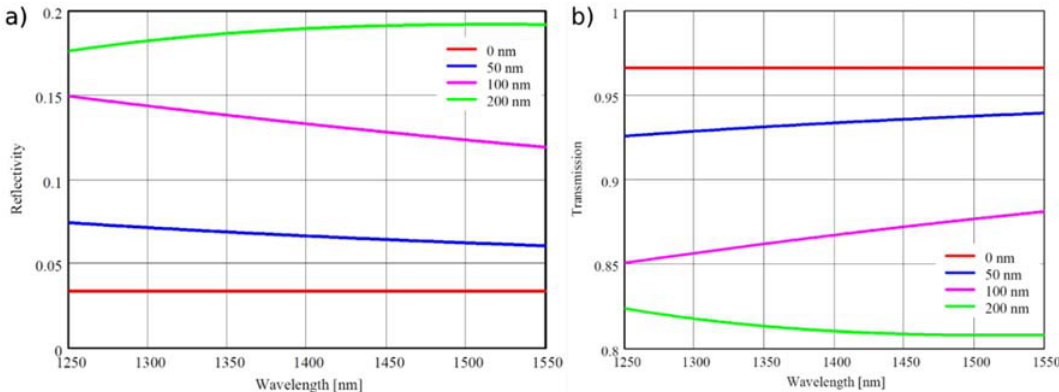
Figure 2. Calculated reflectivity ( a ) and transmissivity ( b ) of a 50 nm, 100 nm and 200 nm ZnO layer on the end face of an SMF-28 fiber. Reflectivity and transmission of an uncoated SMF-28 fiber end face shown for comparison